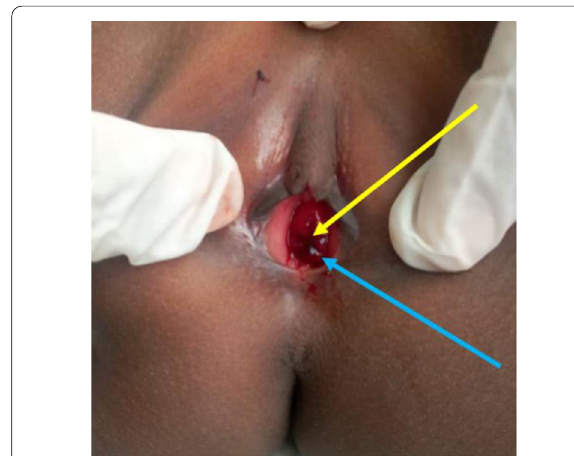
Fig. 1 A patient with urethral prolapse. Notice the urethral meatus (yellow arrow) at the center of the prolapsed mucosa, which the lower part is ischemic and bleeding (blue